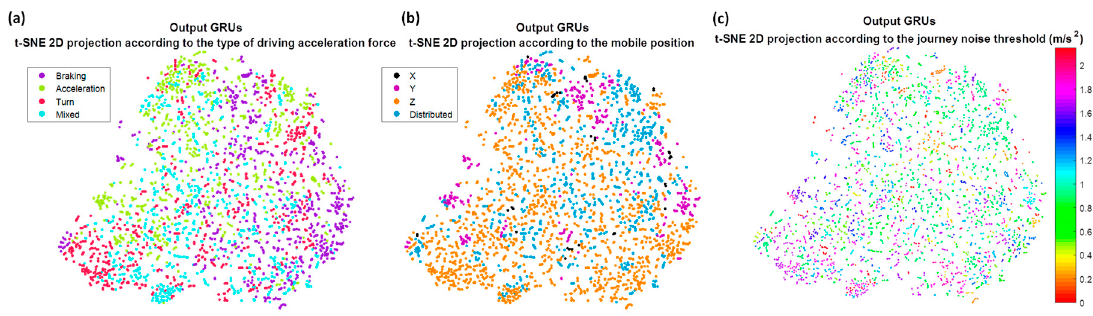
Figure 14. t-SNE 2D projections of feature vectors for horizontal projections input signals to the output of GRU network. ( a ) Projection depends on type of acceleration force. ( b ) According to gravity distribution. ( c ) According to noise threshold of the journey (m/s 2 ).